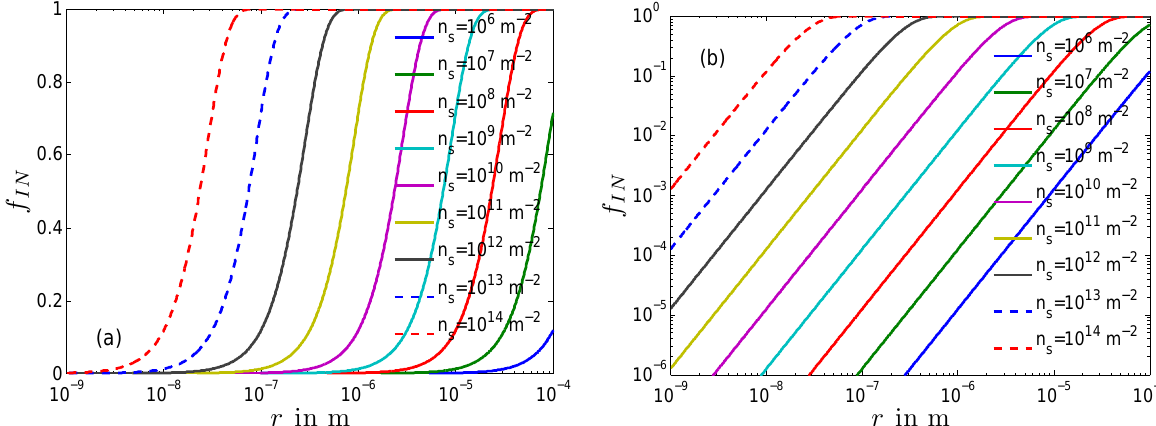
Fig. 10. Activated fraction as a function of aerosol radius for values of different INAS densitites. (b) is identical to (a) except that the y-axis is spaced logarithmically.